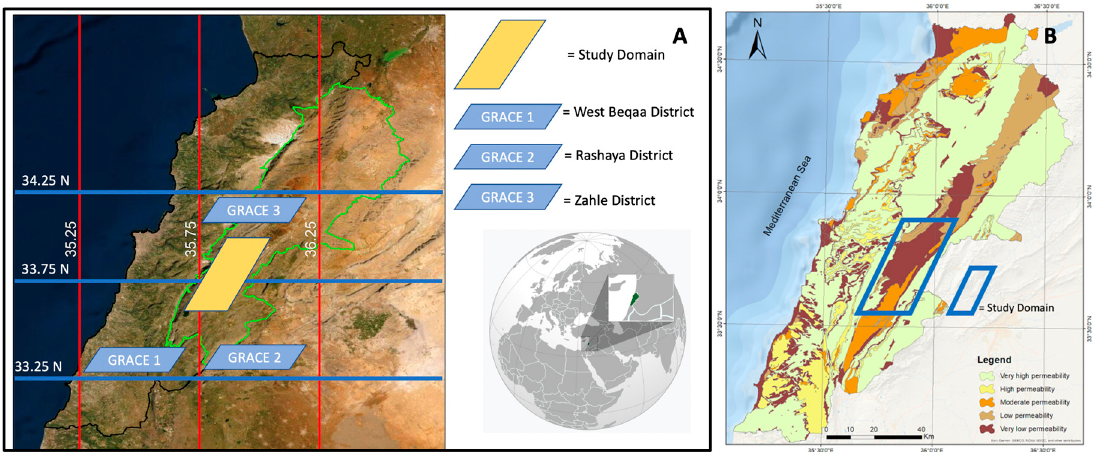
Figure 1. ( A ) Study domain, shown in yellow. There are three Gravity Recovery and Climate Experiment (GRACE) grid cells that cover this area, defined as the West Beqaa, Rashaya, and Zahle Districts. Additionally, the map of Lebanon is shown in relation to the rest of the globe on the bottom right. ( B ) Permeability maps which indicate the potential recharge for Lebanon. Our study domain is a mixture of high to very high recharge (yellow) in the West Beqaa, moderate recharge (orange) in the Rashaya District, and low to very low recharge (purple) in the Zahle District.